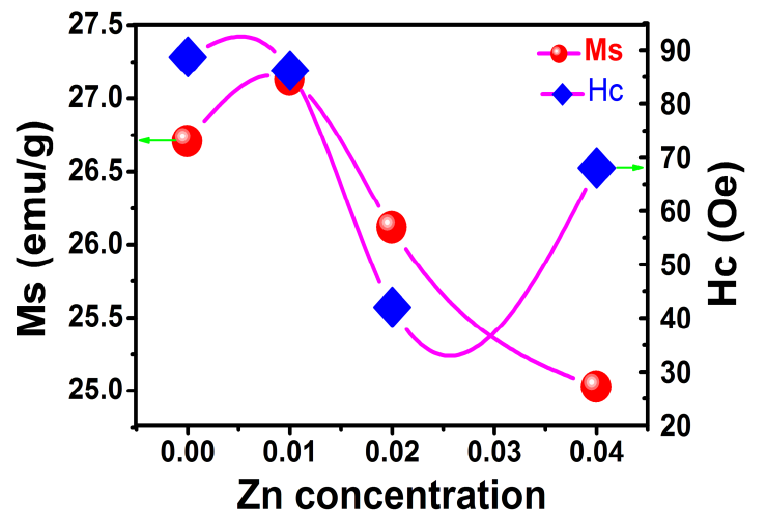
Figure 4. The variation in saturation magnetization and coercivity.